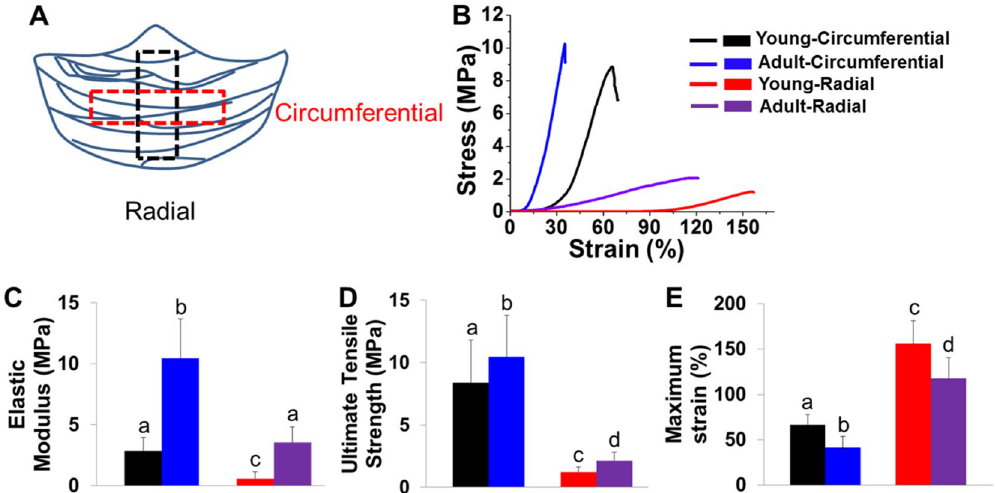
Figure 3. Uniaxial tensile mechanical properties of PV leaflets. ( A ) Preparation and cutting direction of PV leaflets. PV leaflets were cut out in the radial or circumferential direction ( F fibrosa, S spongiosa, V ventricularis); ( B ) representative uniaxial tensile stress–strain curves for young and adult PV leaflets in circumferential and radial directions; summarized elastic modulus ( C ), ultimate stress ( D ), and ultimate strain ( E ) (5 PV leaflets from three pigs for each age group, bars that do not share letters are significantly different from each